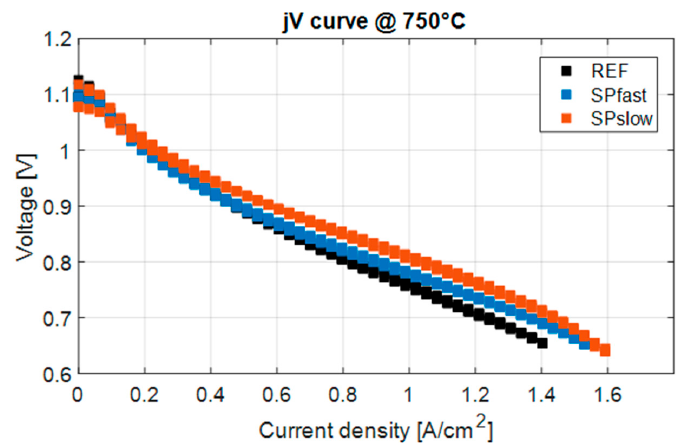
Figure 4. jV curves of samples REF (black markers), SPfast (blue markers) and SPslow (red markers) measured at 750 °C.